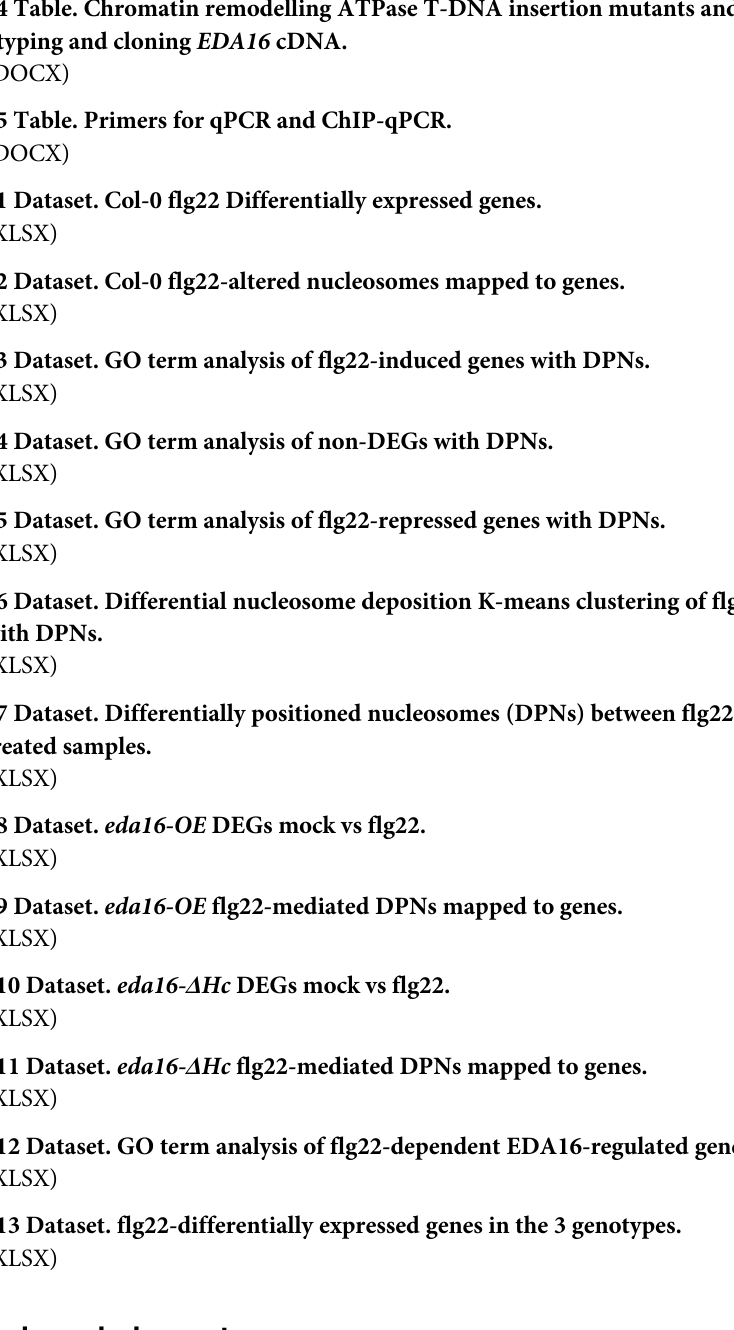
S4 Table. Chromatin remodelling ATPase T-DNA insertion mutants and primers for gen-